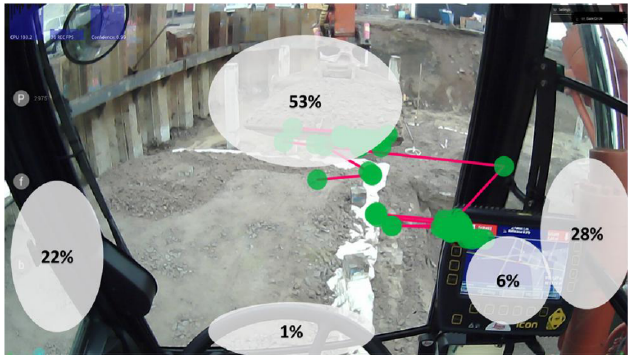
Figure 1. Levels of attention on different areas when operating an excavator, which were measured using an eye-tracker